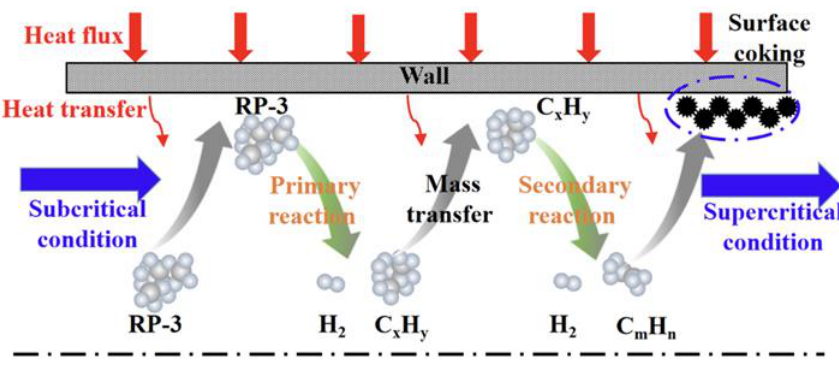
Figure 1. The schematic of heat and mass transfer in the cooling channel [11].